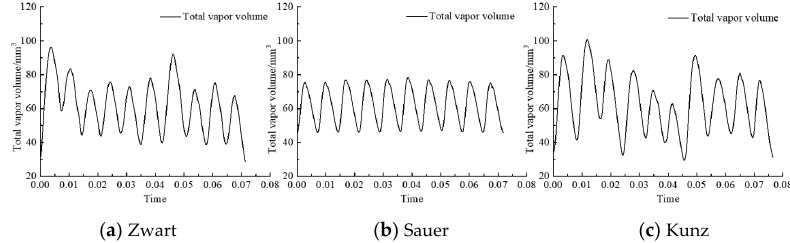
Figure 4. Numerically predicted time evolution of the total vapor volume in the fluid domain with the different cavitation models.